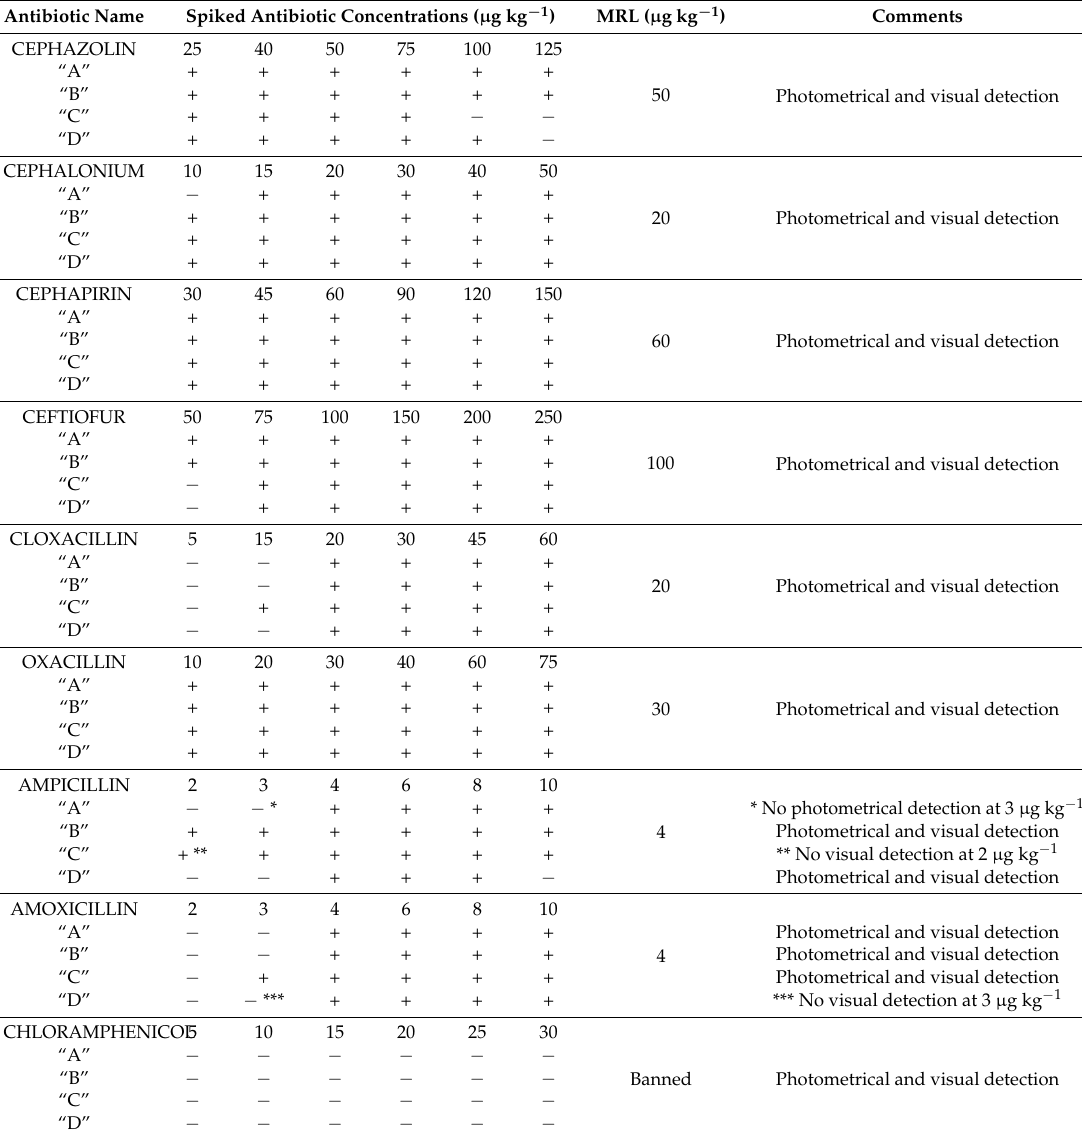
Table 1. Detection limits for selected antibiotics for the examined test